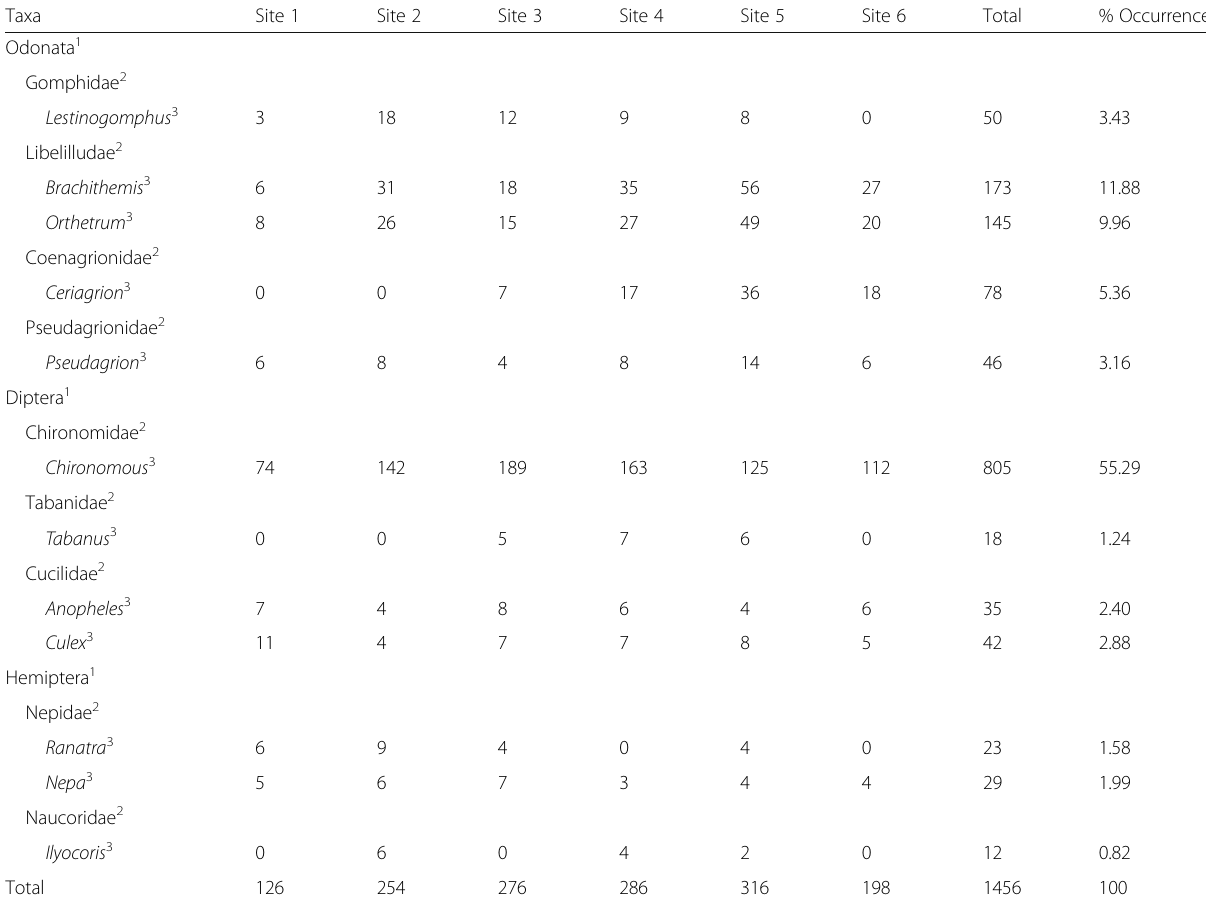
Table 3 presents the checklist of aquatic insects occur- ring in the stream. A total of 1456 aquatic insects which comprises of 12 genera in nine families and three orders were collected at the six study sites. Study sites 3 and 4 had 11 taxa, site 2 had 10, site 1 had 9, while site 6 had Table 3 Checklist of aquatic insects ’ occurrence at the six study sites at Aahoo stream, Akure, Nigeria